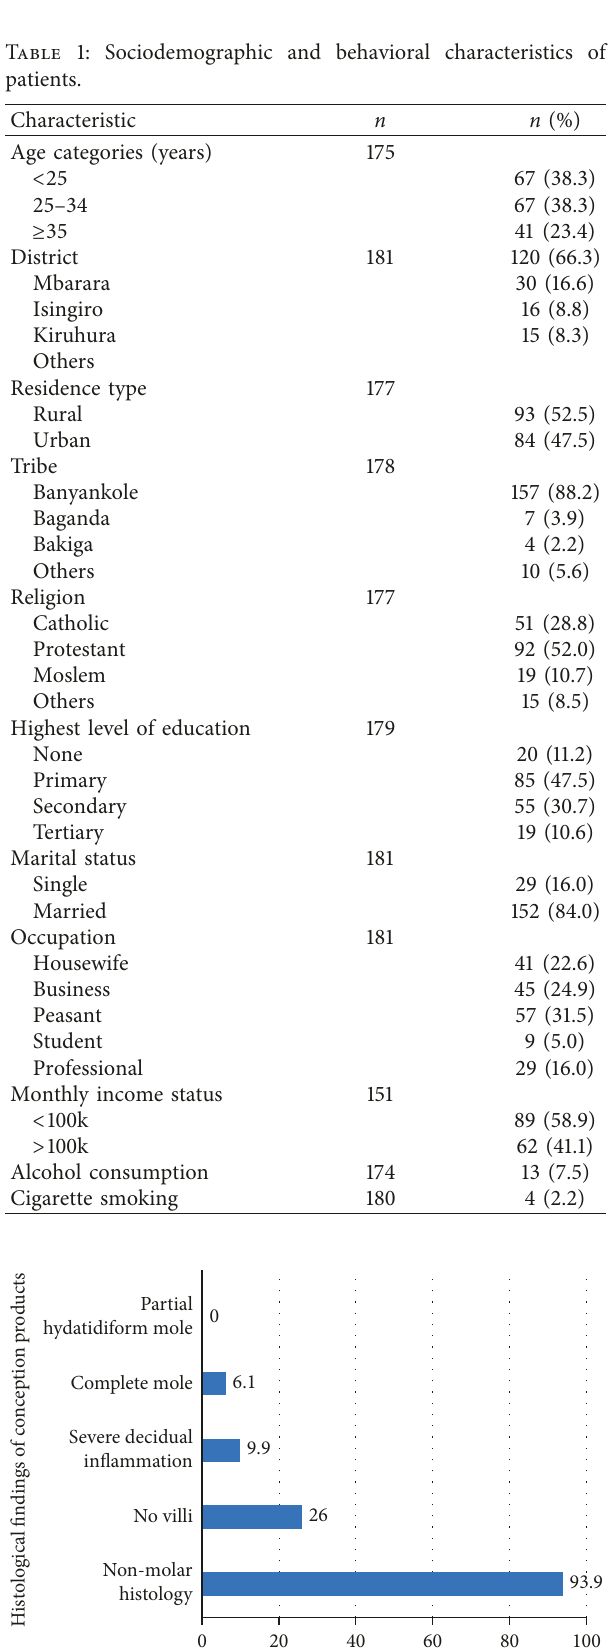
Figure 2: The histopathological